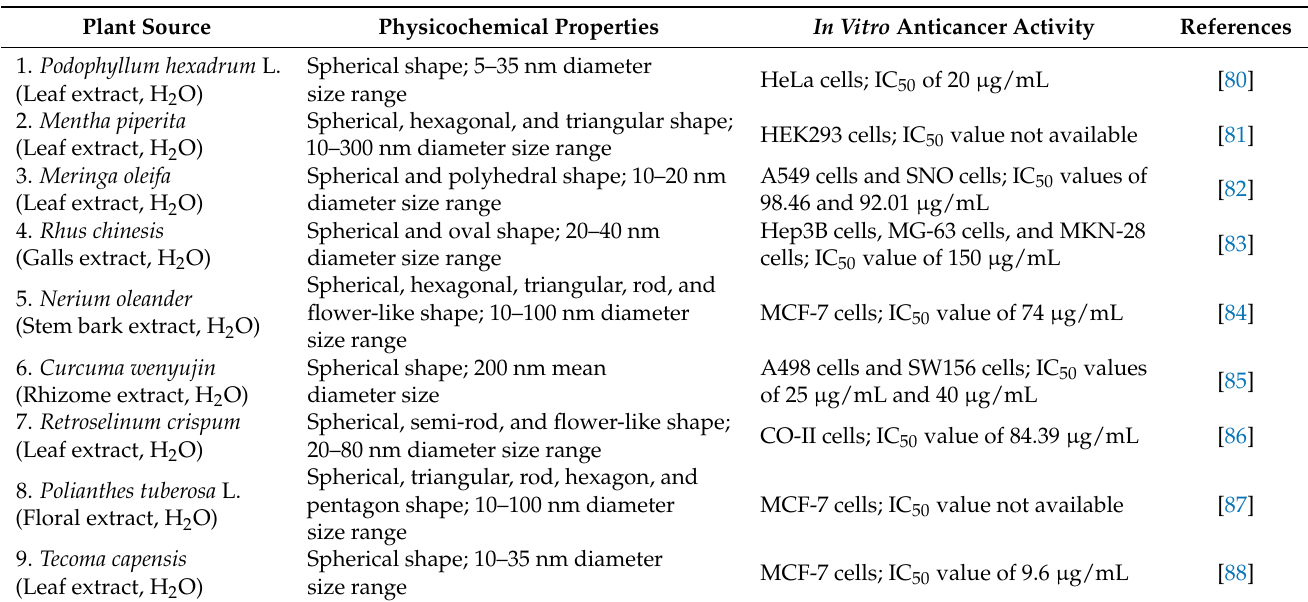
Table 1. Anticancer activity of various biosynthesized gold